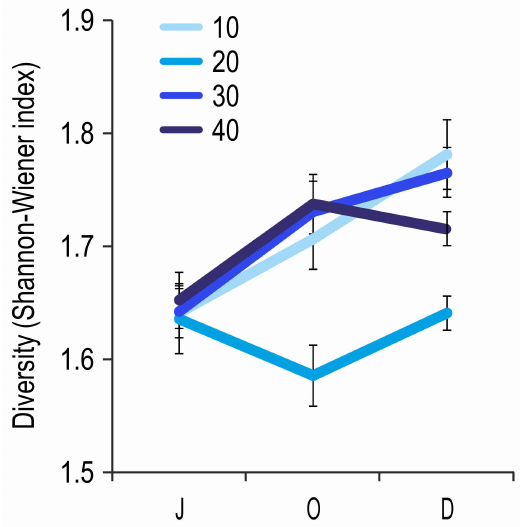
Figure 6. The community structure, expressed by mean ( ± se) diversity (Shannon–Wiener index), of the Portofino MPA at the three time periods investigated (J = June; O = October; D = December).